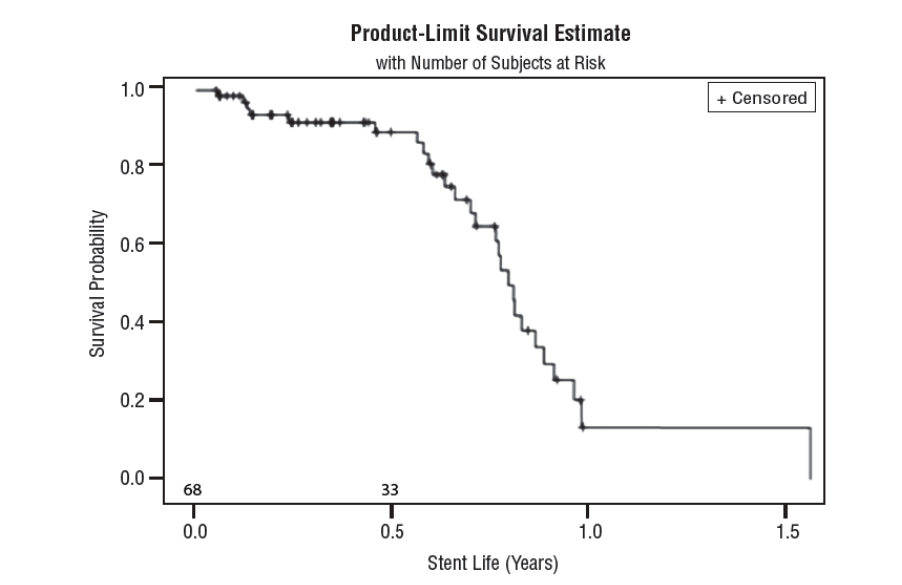
Figure 1 - Kaplan-Meir Analysis Median stent life calculated by Kaplan-Meier method: 288.4 days (95% CI= 277.4-321.2